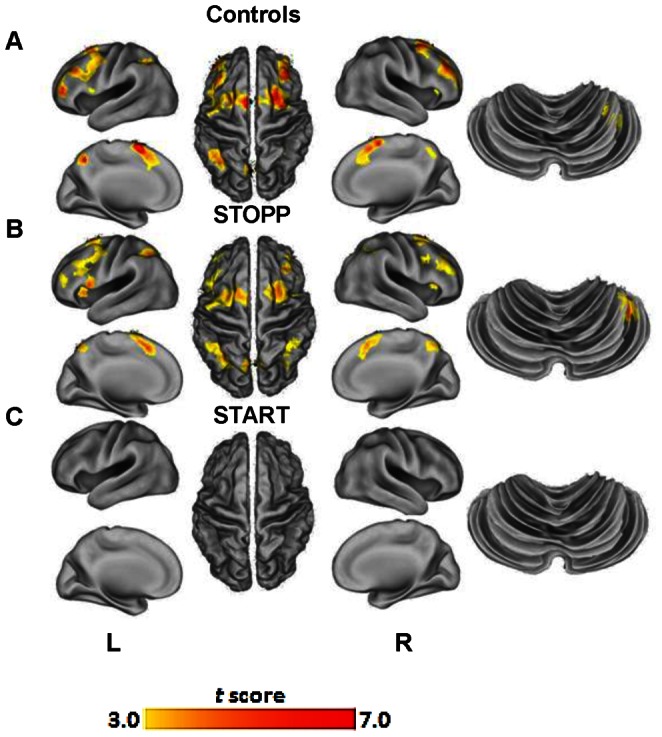
Acute exercise prompts changes in neural networks observed during cognitive task.Exercise reduced cerebral and cerebellar activity for all groups. (A) Controls activated areas in agreement with normal working memory function in the frontal and parietal lobes. (B) STOPP subjects activated normal working memory regions as well as compensatory right cerebellar recruitment. (C) The largest decrement in activity was in the START group that had no net change in regional blood flow to the cerebrum or cerebellum. Whole-brain maps are displayed at P<0.001 and were cluster corrected for multiple comparisons at P<0.05 using AlphaSim.